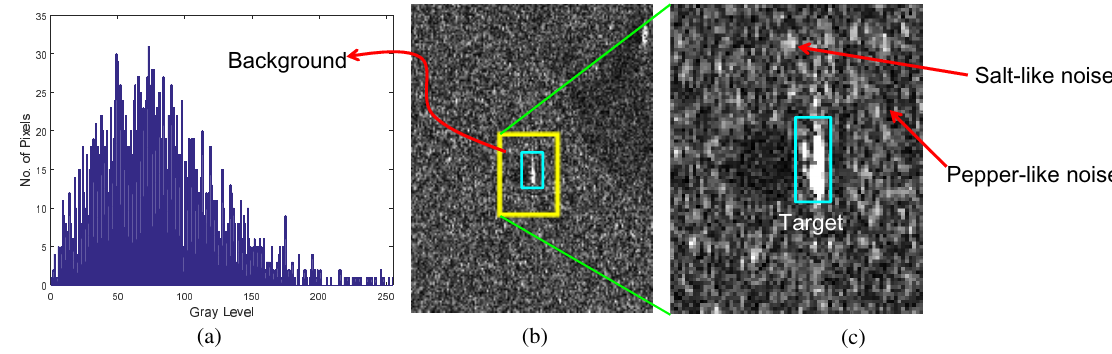
Figure 8. Proposed decision level fusion-based extended SAR/IR target detection using modBVMT and RANSARC-based registration: ( a ) distribution of background region, ( b ) target and background region, and ( c ) salt and pepper